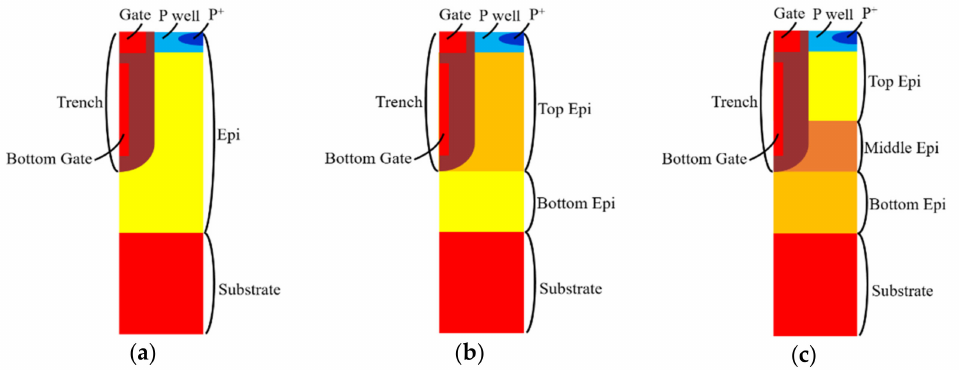
Figure 1. and ( c ) triple EPIs.